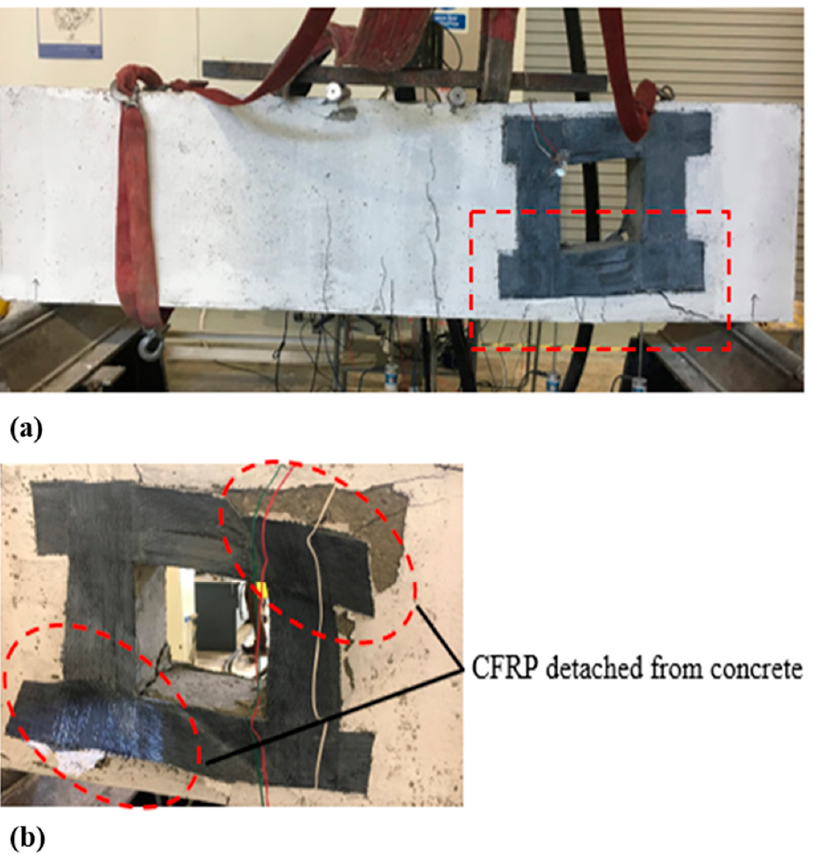
Figure 10. ( a ) Failure mode and cracking pattern of deep beam B2b; and ( b ) detachment and peeling of the carbon fiber reinforced polymer (CFRP) sheet from the concrete.